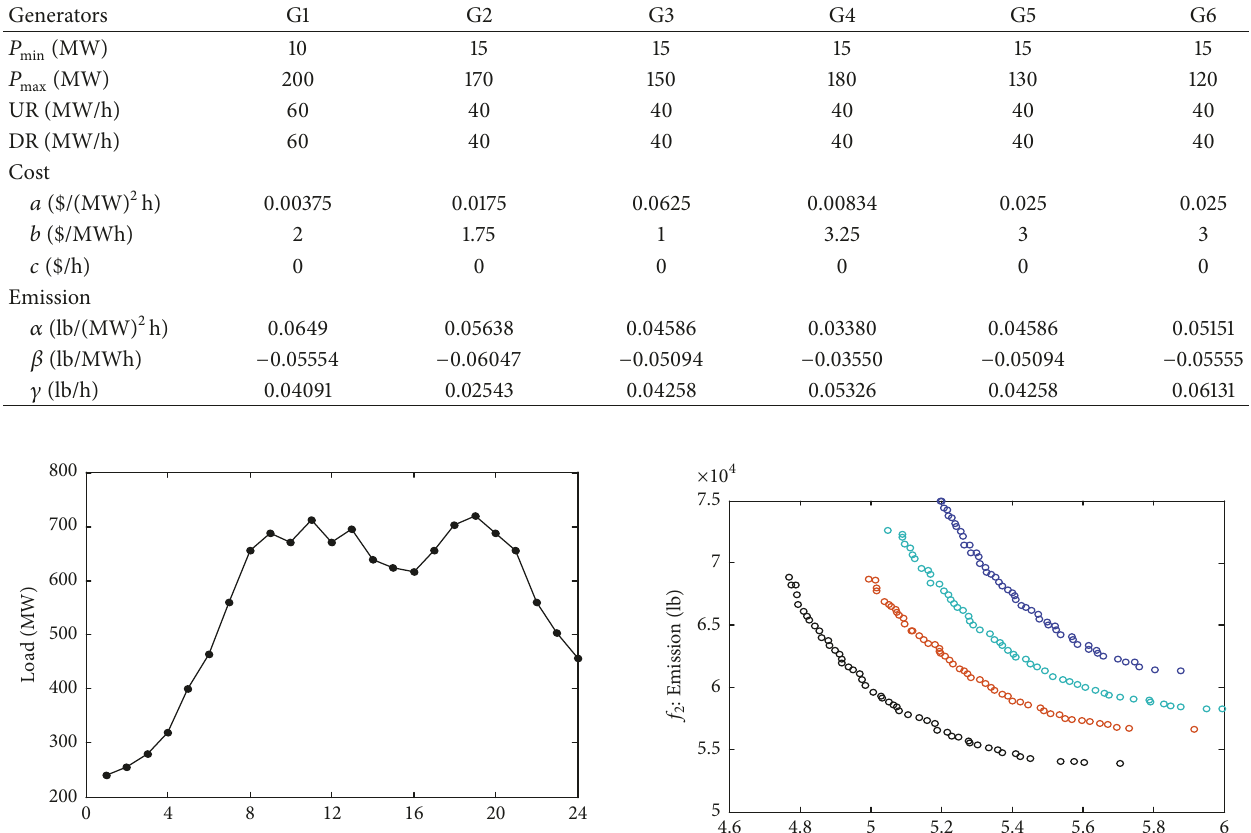
Table 2: Generator parameters.